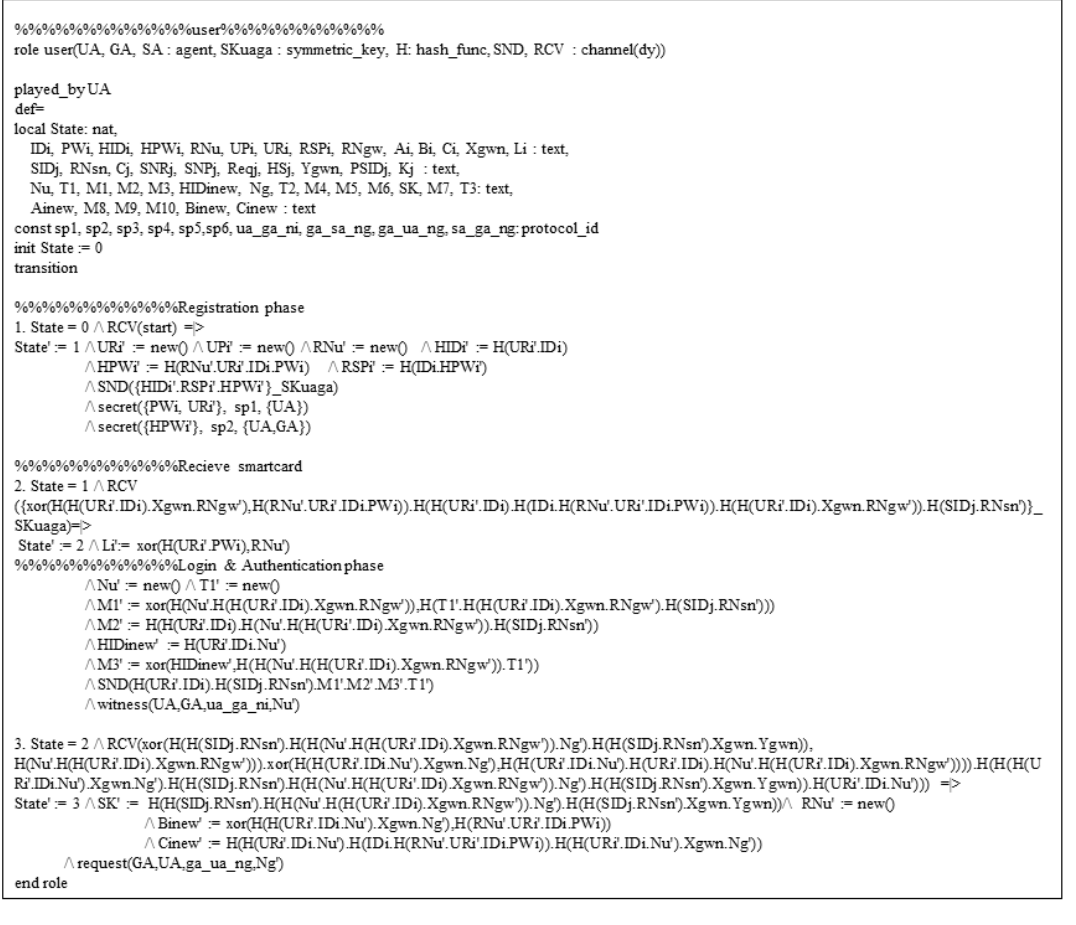
Figure 5. HLPSL specification for